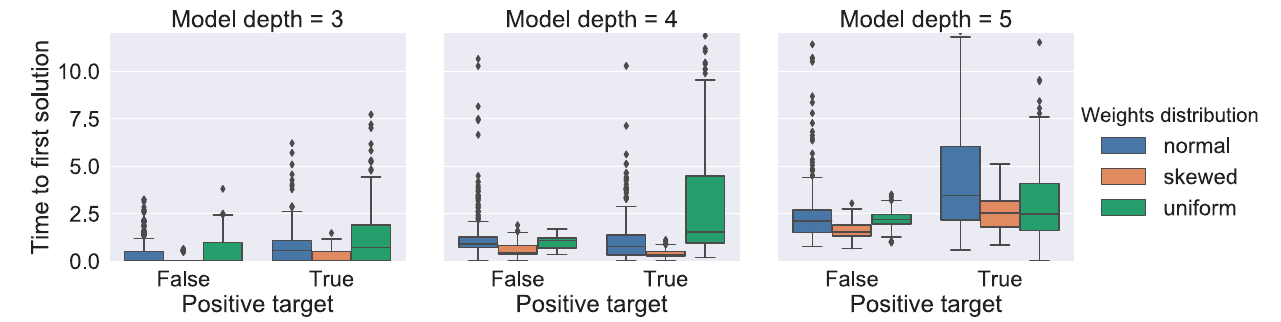
Figure 14. Boxplots for the time in seconds (smaller is better), required to find the first optimal alternative for different benchmark models.